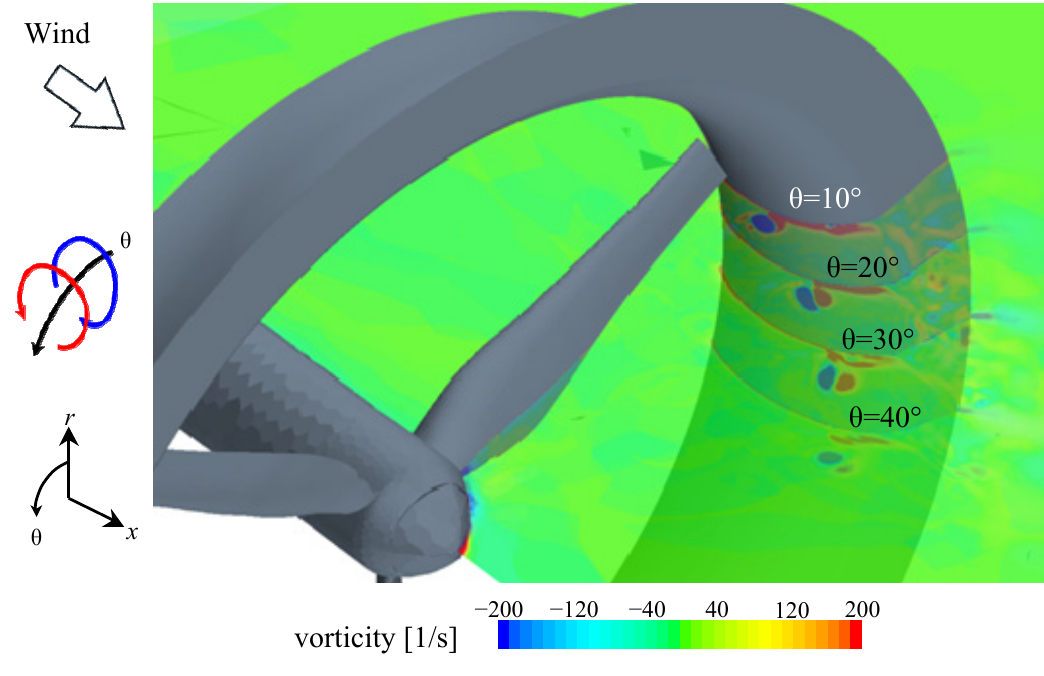
Figure 13. θ -component of the vorticity inside the compact-type Wind-Lens turbine including that of the blade tip vortex and the induced counter-rotating